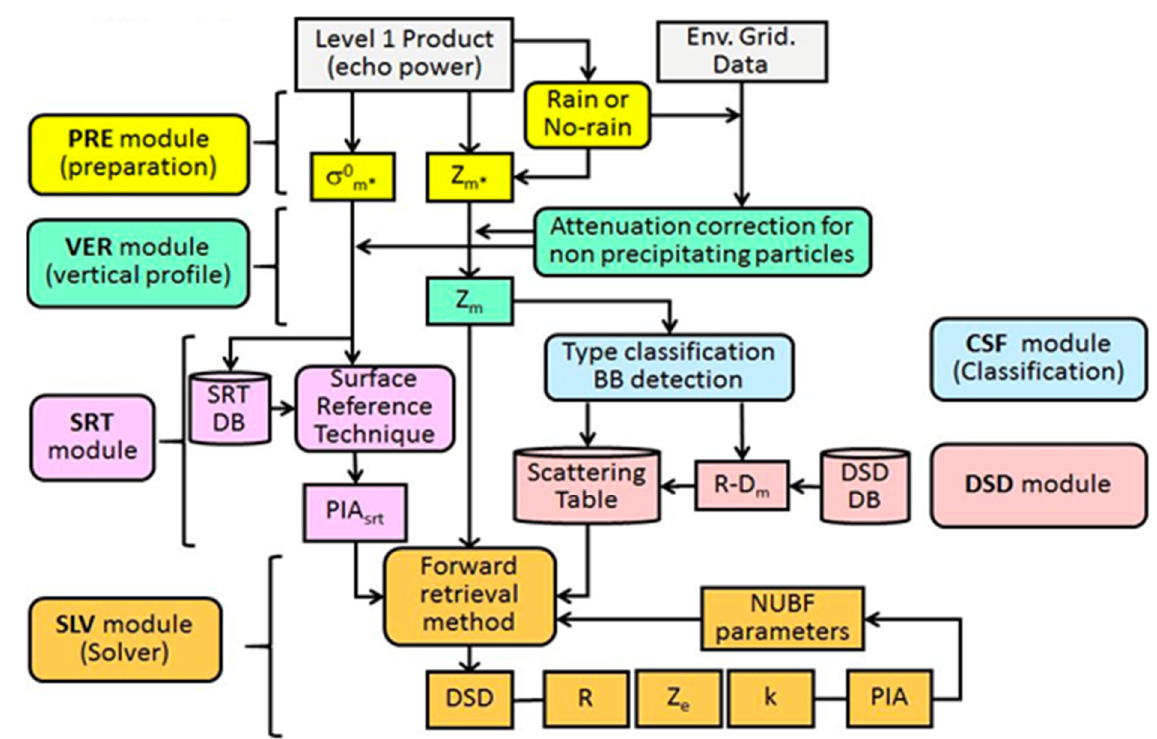
Figure 1. Schematic diagram of the standard DPR algorithm.